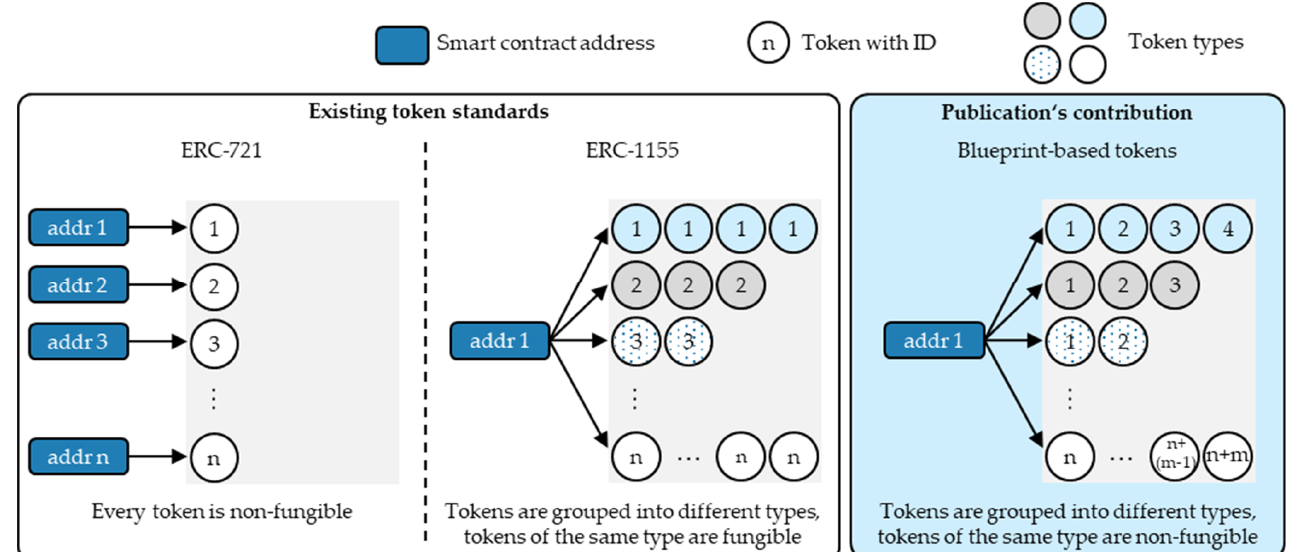
Figure 4. Positioning of blueprint-based tokens in the NFT standard landscape.